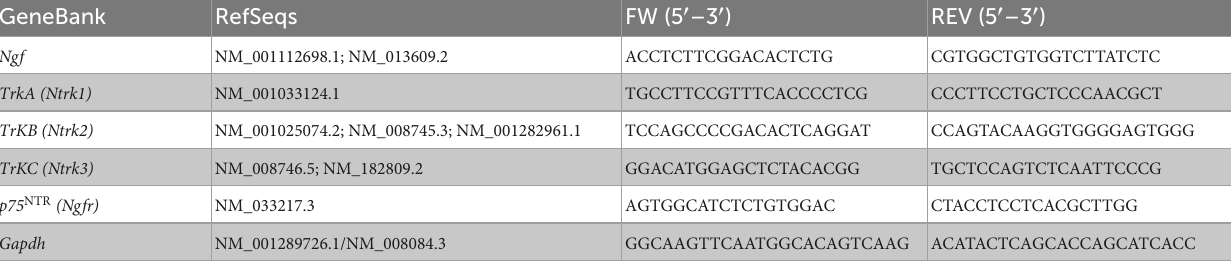
TABLE 2 List of the primer sequences.